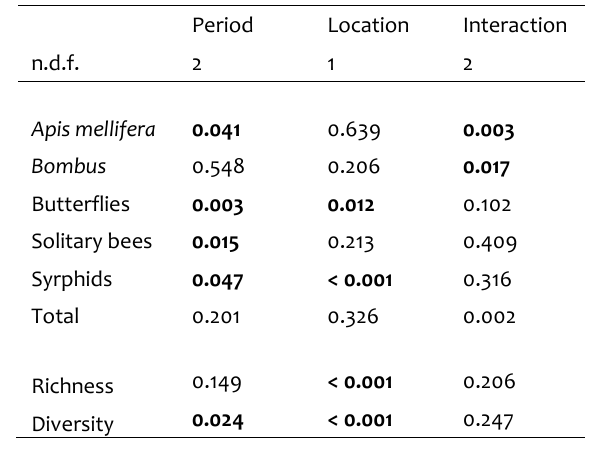
Results of REML analysis (P-values) examining the response of insect abundance and pollinator diversity to: (A) crop type (APP v OSR) and location (crop centre v field margin) during the main crop flowering period (B) location (crop centre v field margin) and study period considering only the insects recorded in the apple sites and (C) crop type (APP v OSR) and study period considering the insects in both crops but only in the field margins. Insect abundance data were square root transformed before analysis. n.d.f. – numerator degrees of